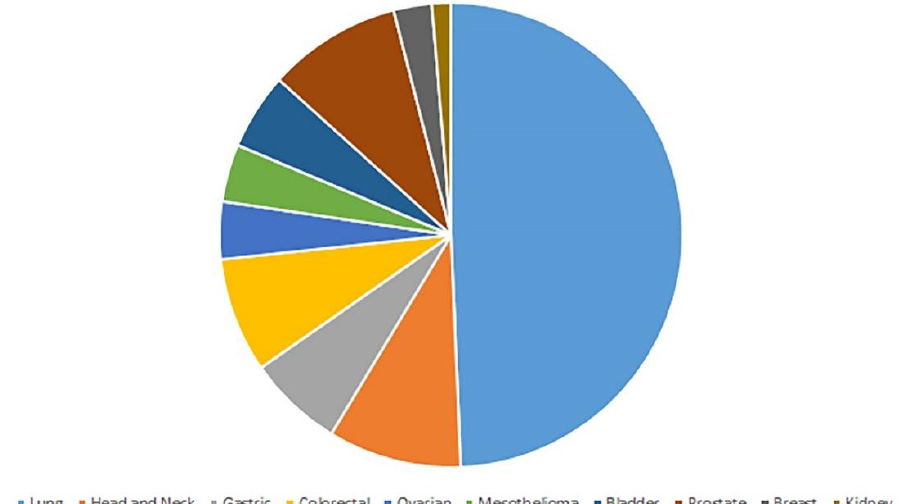
Figure 3. Distribution of cancer types across the retrieved studies.